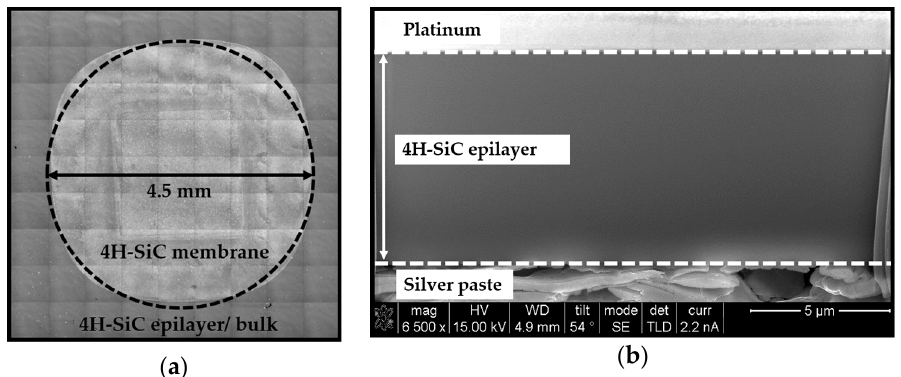
Figure 1. ( a ) Laser Scanning Microscope (LSM) image of the 4H-SiC membrane using stitching mode, obtained after the electrochemical etching (ECE) process. Circular insert added to show that the 4H-SiC membrane can be assimilated as a circle. ( b ) Focused ion beam (FIB) cross-section image allowing the membrane thickness determination.